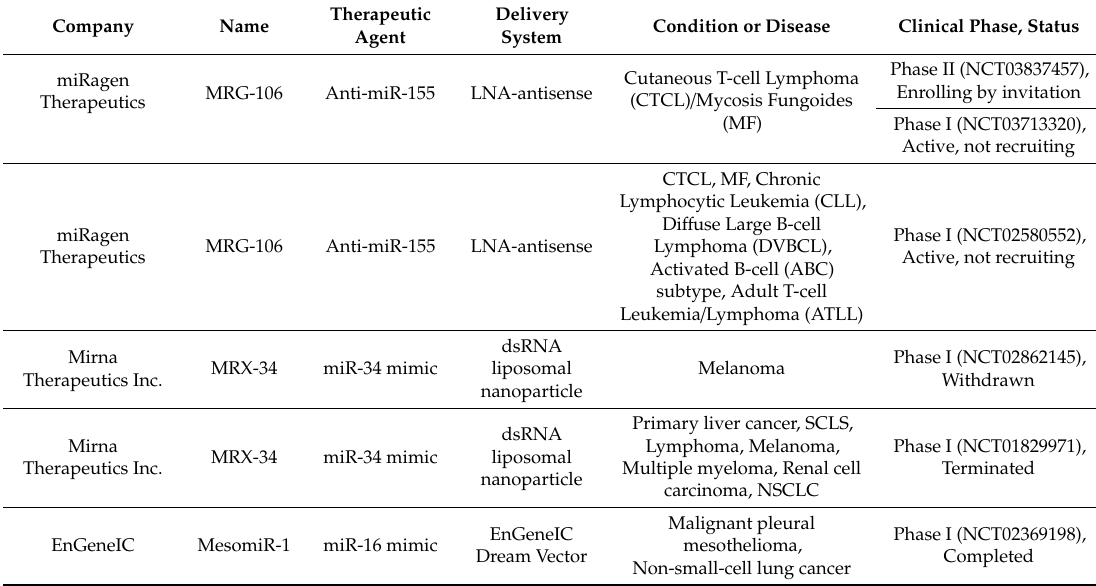
Table 3. MiRNA-based Therapy Clinical Trials in the